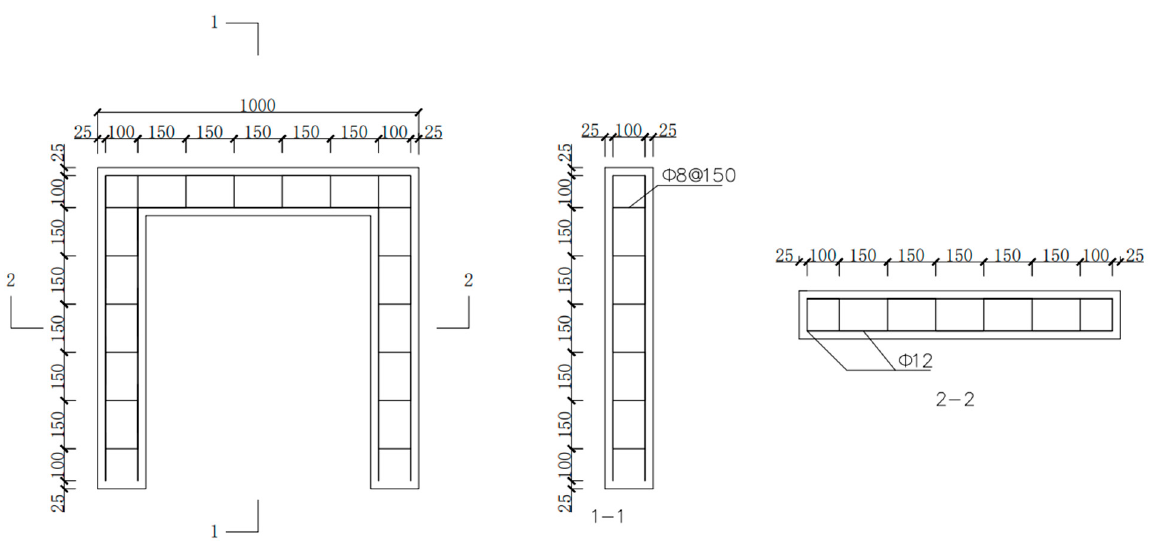
Figure 7. Reinforcement of frame structure.